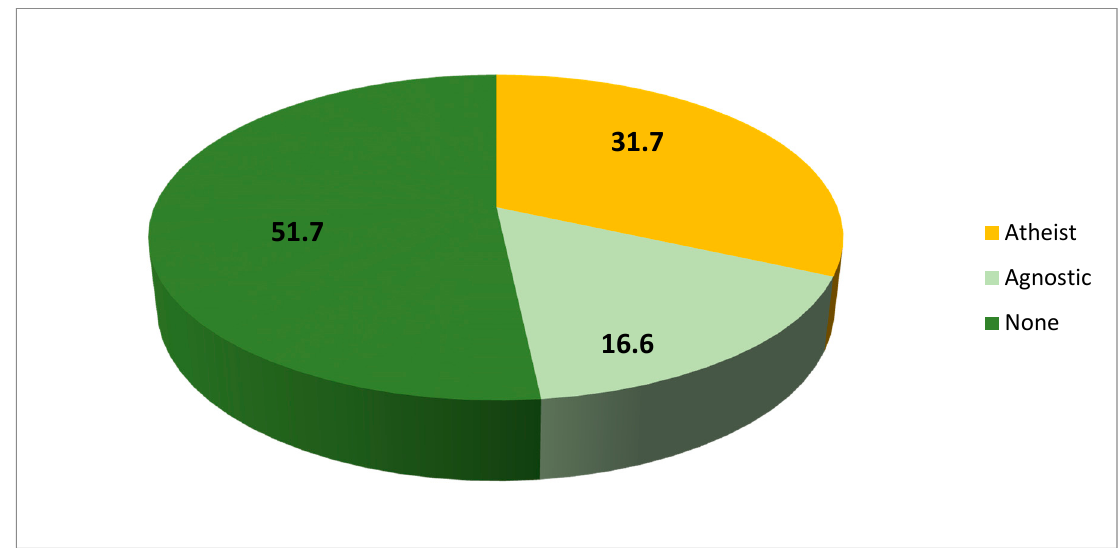
Figure 2. Distribution of the religiously unaffiliated (in %). Based on total religiously unaffiliated = 382 cases. Source: Author’s elaboration based on the Second National Survey on Religious Beliefs and Attitudes. Society, Culture and Religion Program, CEIL-CONICET, 2019.